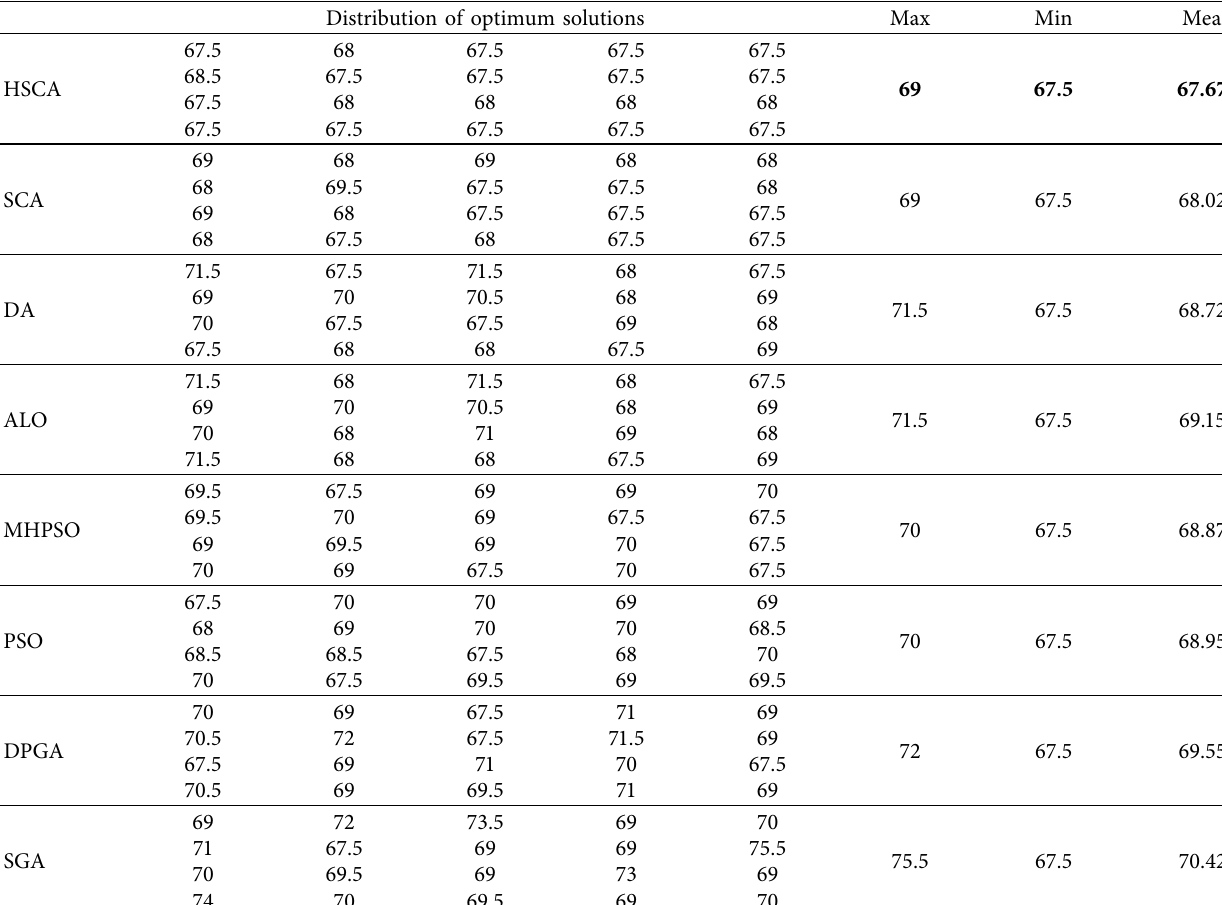
Table 3: Best solutions obtained in case study 1 with diferent algorithms after 20 runs. Distribution of optimum